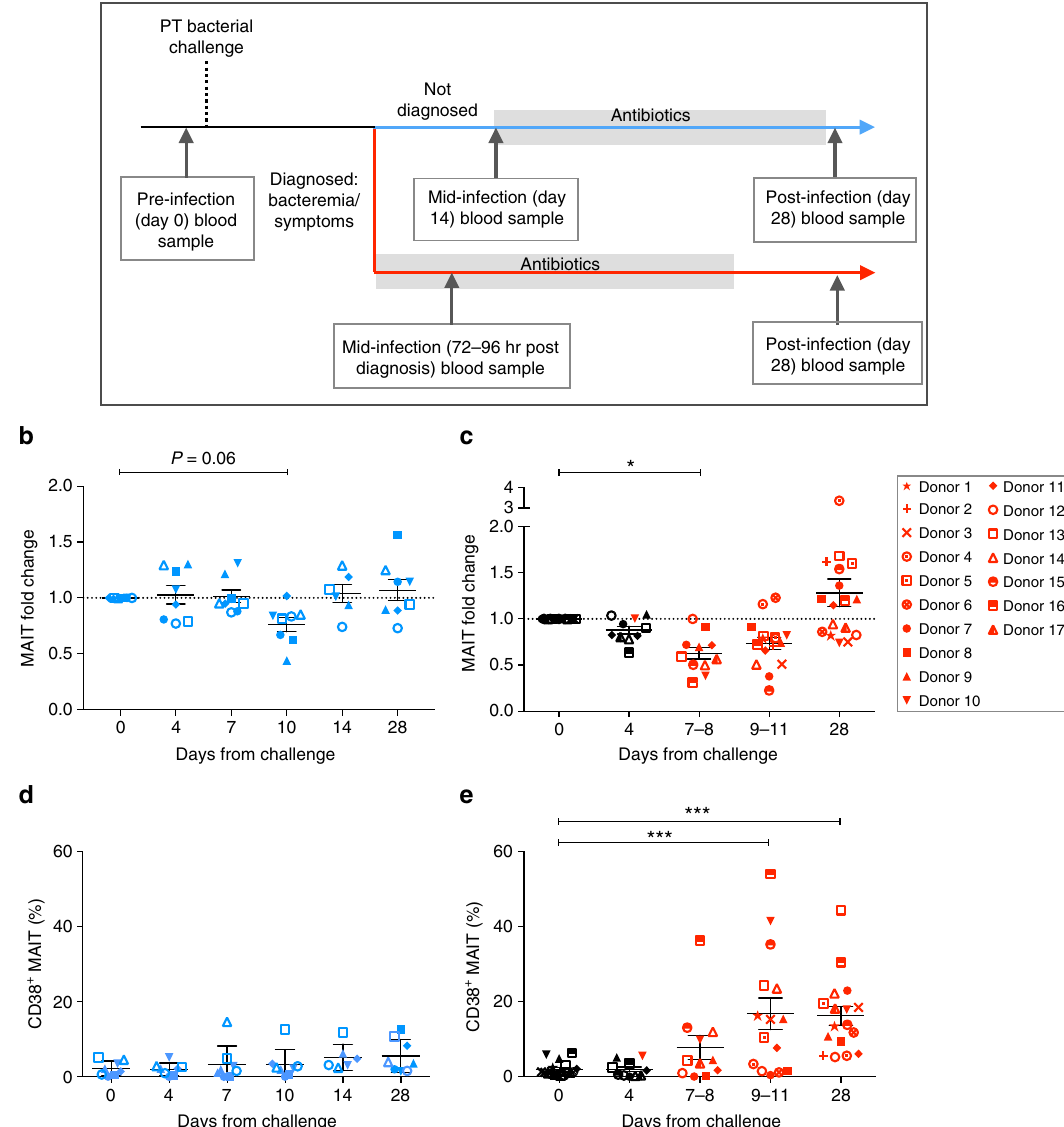
Fig. 1 MAIT cell frequency and phenotype during S . Paratyphi A infection. a Outline of the blood sampling protocol for the controlled human S . Paratyphi A infection. PBMCs were isolated at various time points from 25 individuals challenged with live S . Paratyphi A and analyzed by fl ow cytometry. Graphs showing the frequency of MAIT cells in the CD3 + T-cell compartment represented as fold change from baseline in individuals b not diagnosed ( n = 8) or c diagnosed with enteric fever ( n = 17). Graphs showing the percentage of activated MAIT cells in challenged individuals d not diagnosed and e diagnosed with enteric fever analyzed by expression of CD38. Each symbol represents a participant and a key for diagnosed individual identi fi cation is provided. For diagnosed individuals, infection was diagnosed between day 4 and day 7, with black symbols representing samples collected prior to diagnosis and red symbols representing samples taken on/after diagnosis. Line indicates mean and error bars represent standard error of the mean (SEM). Statistical signi fi cance was calculated using one-way analysis of variance (ANOVA) with Dunnett ’ s test, where * P < 0.05 and *** P < 0.001. PT, S . Paratyphi